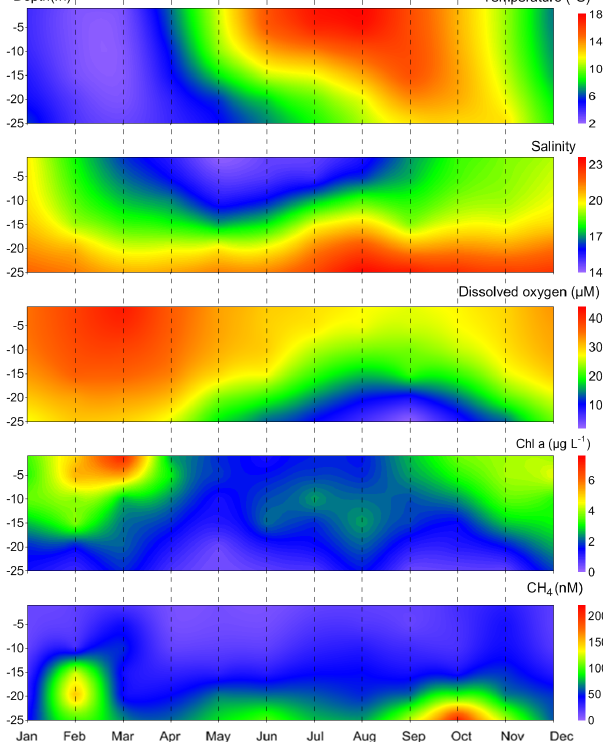
Figure 3. Mean seasonal variations in temperature, salinity, dis- solved O 2 , Chlorophyll a and CH 4 at BE during 2006–2017. CH 4 concentrations in December 2014 were excluded in